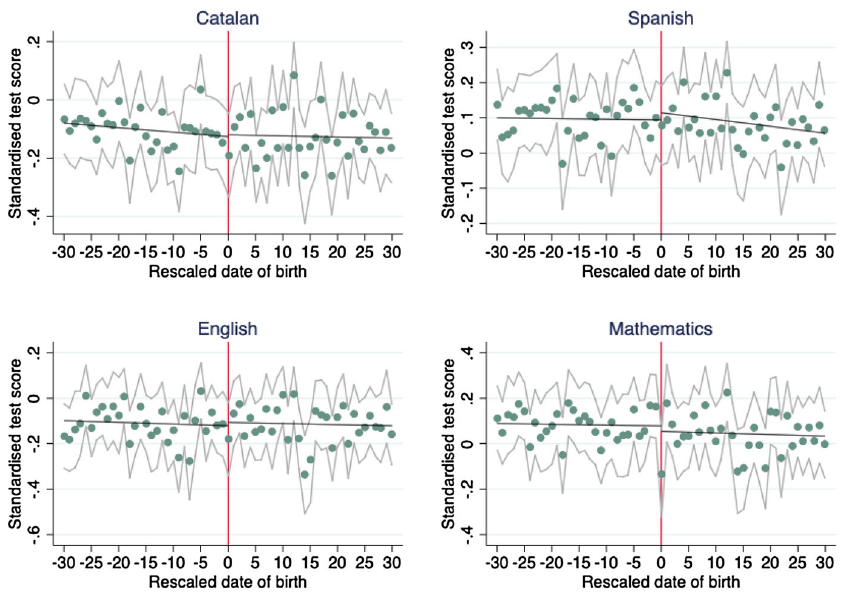
Fig. 9 Placebo RD plots by subject, 2018